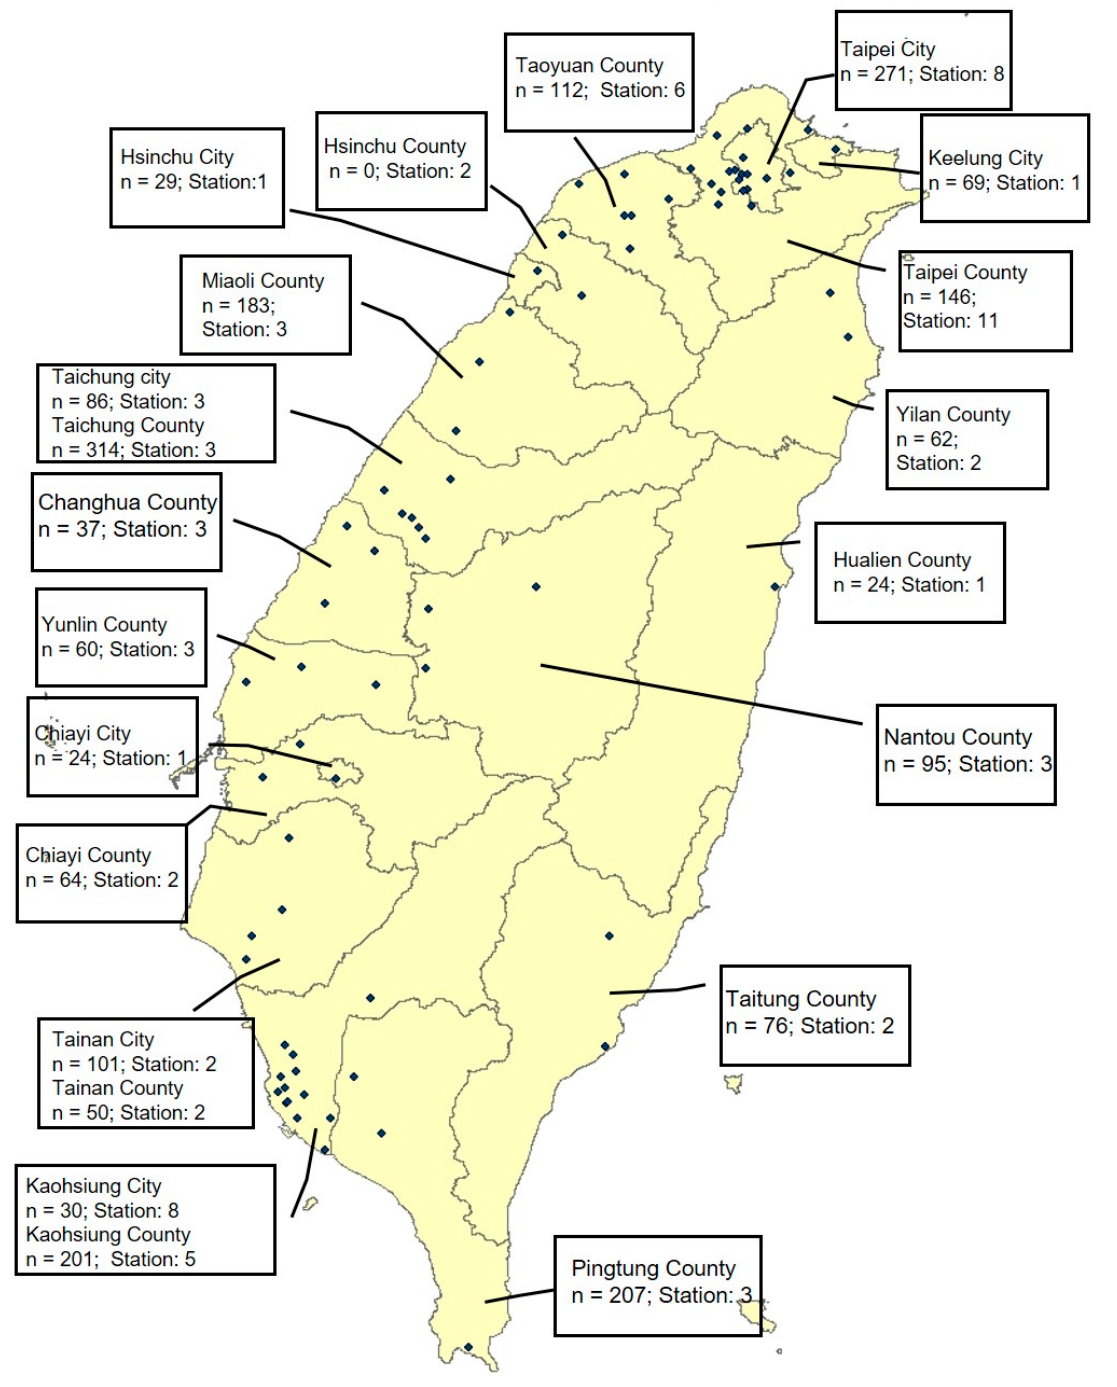
Figure 2. Distribution of study population (n = 2241) in 1996 and monitoring stations in each city/county in Taiwan.